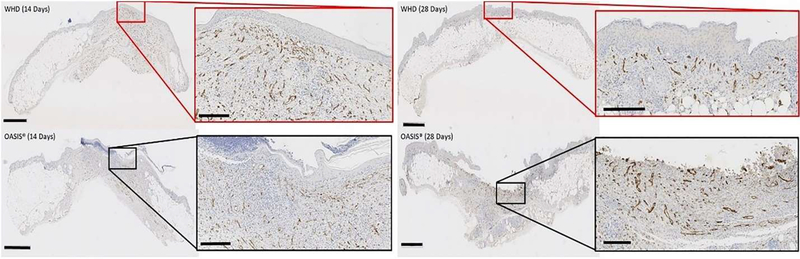
CD31 reacted tissues used to quantify the presence of microvasculature in the wounded tissue sites. Both treatments had a large amount of microvasculature present at 14 days (Left). While there was no significant difference in the amount of microvasculature measured per square micron, the area measured in the WHD was smaller due to the progression of wound healing in the 28-day samples (Right). Macro-image scale bars = 1 mm, micro-image scale bars = 200 μm.